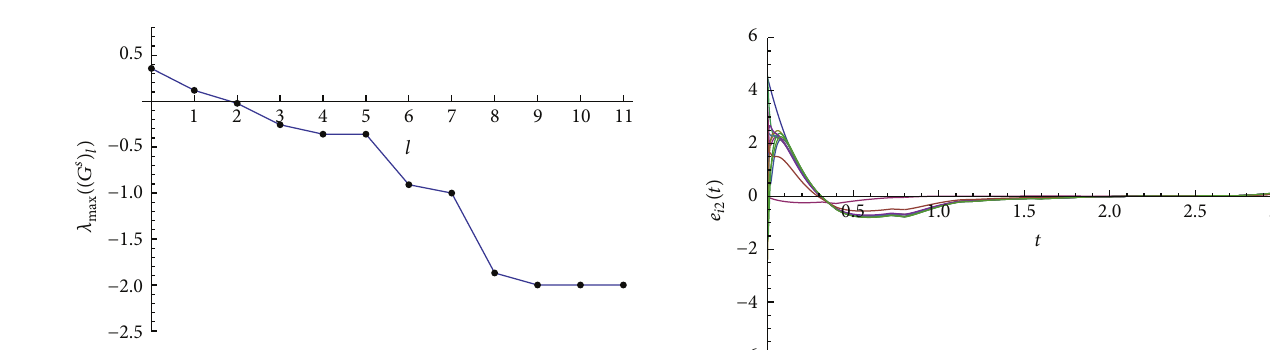
Figure5:Synchronouserror 𝑒 𝑖2 (𝑡) ofcomplexdelayednetwork(26).